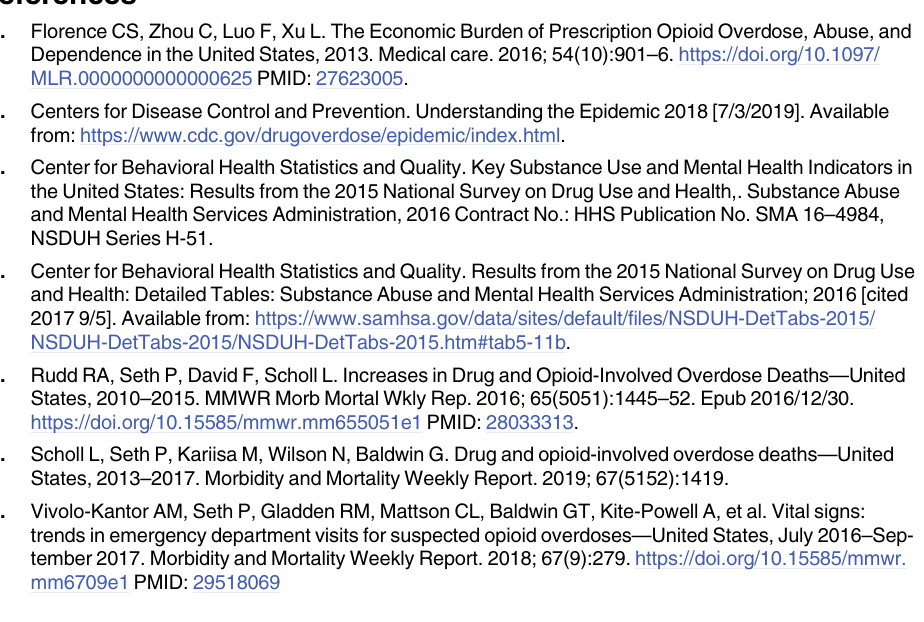
S2 Table. Percent change and predicted probabilities of substance use disorder patients and visits by grantee status, from 2010 to